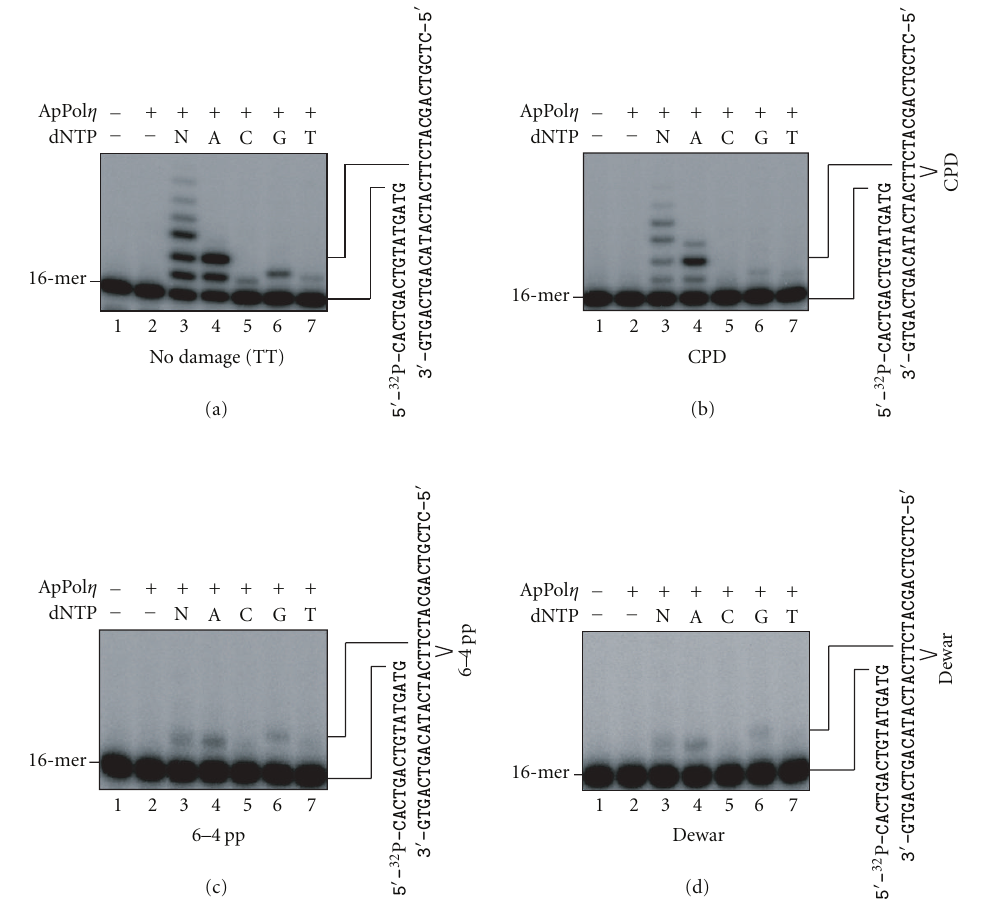
Figure 4: Selectivity of nucleotide incorporation by ApPol η opposite undamaged TT (a), CPD (b), 6–4 pp (c), and Dewar (d). ApPol η (12 fmol in lanes 2–7) was incubated with each primer-template in the presence of the four dNTPs (lane 3), the indicated dNTP (lanes 4–7), or the absence of dNTP (lane 2). Lane 1 contained no enzyme. The reactions were incubated at 37 ◦ C for 5 minutes, and then were subjected to 15% polyacrylamide/7.5 M urea gel electrophoresis. The autoradiograms of the gels are shown.